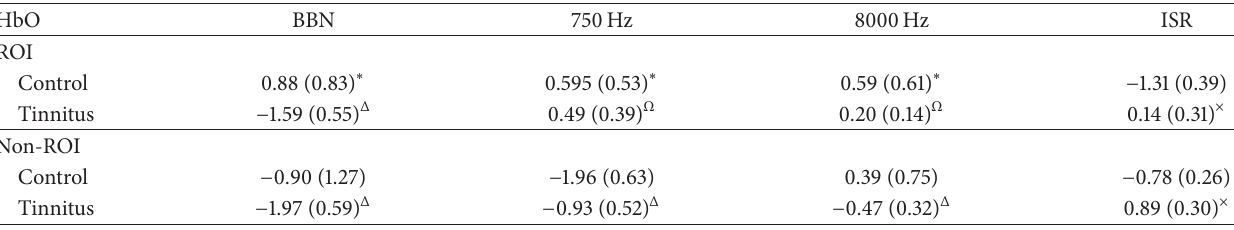
Table 1: Mean oxy-hemoglobin (HbO) concentration and standard error (parentheses) from region (ROI) and nonregion of interest (non- ROI) during silence (interstimulus rest; ISR) and stimulation (750 Hz, 8000 Hz, broadband noise; BBN) between tinnitus and control. The unit of concentration is micromolar ( 𝜇 M). Independent and pairwise 𝑡 -test analyses were conducted as shown to assess hemodynamic response differences during the various experimental conditions within and between groups for all conditions. Relative values to zero reflect a hemodynamic response deactivation (negative) versus activation (positive) in hemodynamic response (statistically significant as compared to ISR in controls ∗ ; as compared to ISR in tinnitus Δ ; as compared to BBN in tinnitus Ω ; and between tinnitus and controls × ; 𝑝 < 0.05 ).